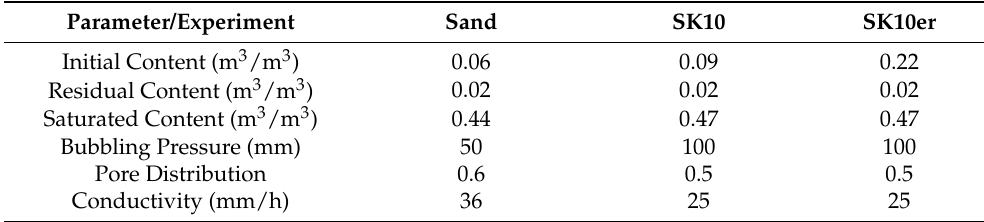
Table 3. Smith Parlange initial parameters that were used for the rainfall–runoff